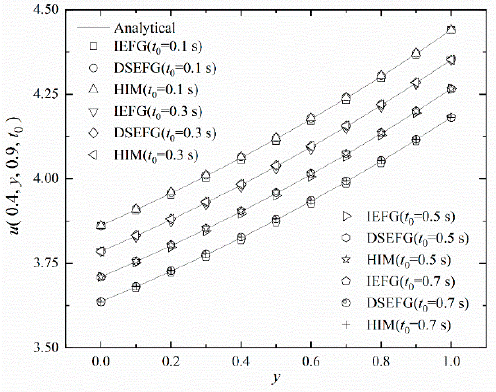
Figure 10. Calculation results along y -axis when t 0 is different.